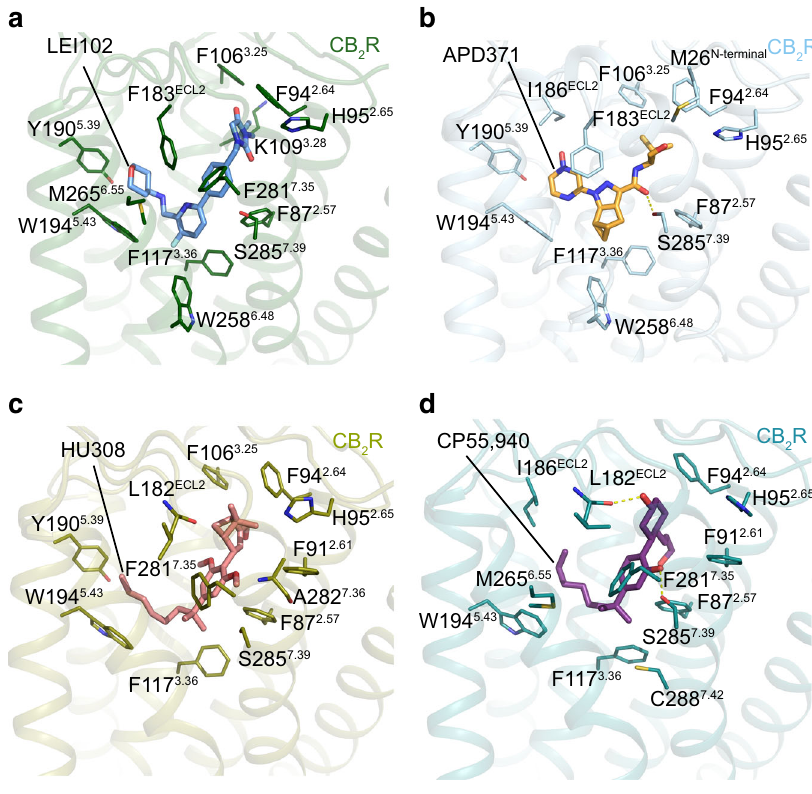
Fig.3|KeyinteractionsbetweenCB 2 Randagonists. Keyresiduesinvolvedin a LEI-102, b APD371, c HU308,and d CP55,940bindinginCB 2 R-G i complexstructures.The amino acids involved in interactions are shown as sticks, hydrogen bonds are highlighted with yellow dashed lines. Same color codes as in Fig.